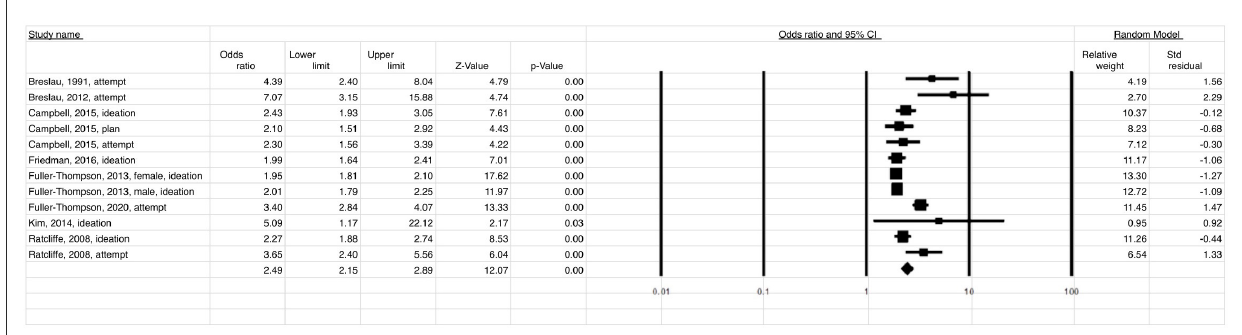
FIGURE2 Relationship between suicide ideation and attempt (OR = 2.49) in patients with migraine when compared to healthy controls.